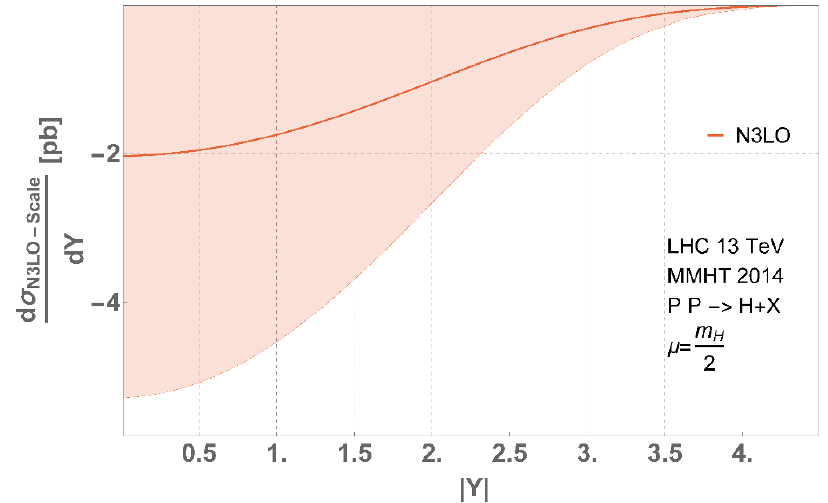
Figure 7. N3LO correction to the absolute rapidity distribution arising from coe(cid:14)cients of log- arithms of the perturbative scale (cid:22) . The band corresponds to a variation of the scale within the interval (cid:22) 2 [ m h = 4 ; m h